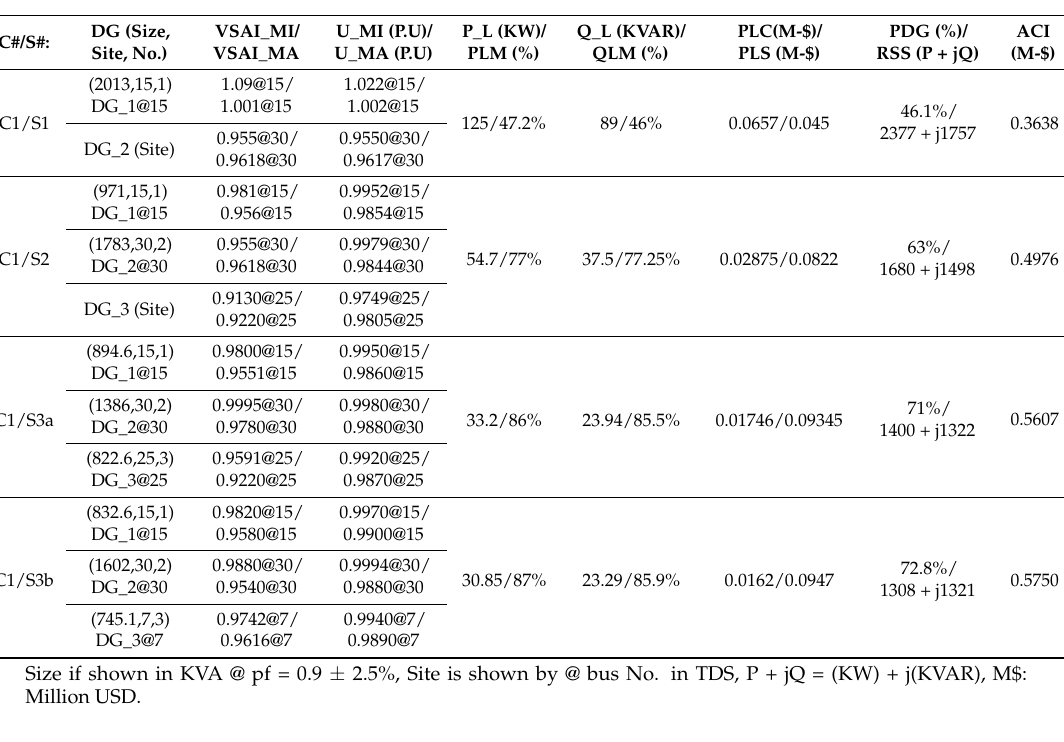
Table 2. Results of proposed planning approach under Case 1 (33-bus-MDS) aim at U_Max.